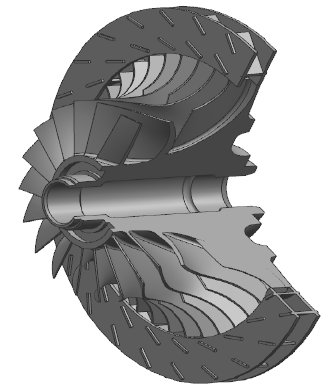
Figure 1. 3D view of the original centrifugal compressor.